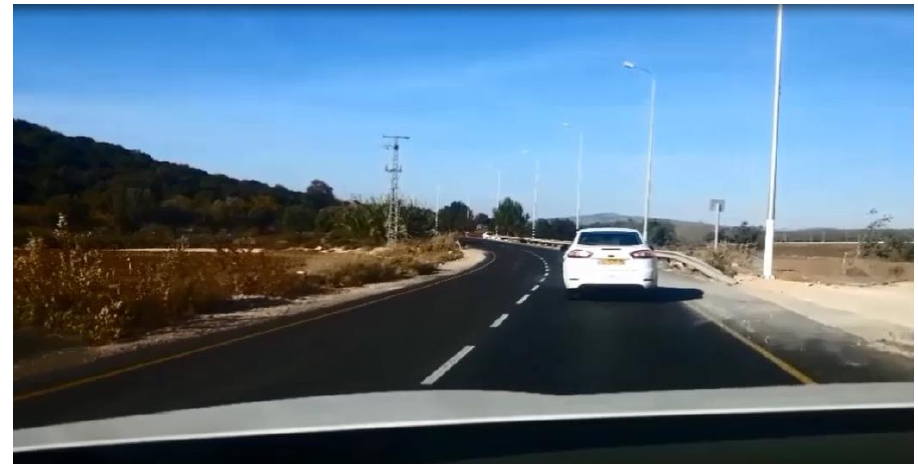
Figure 2. Screenshot of the second overtake